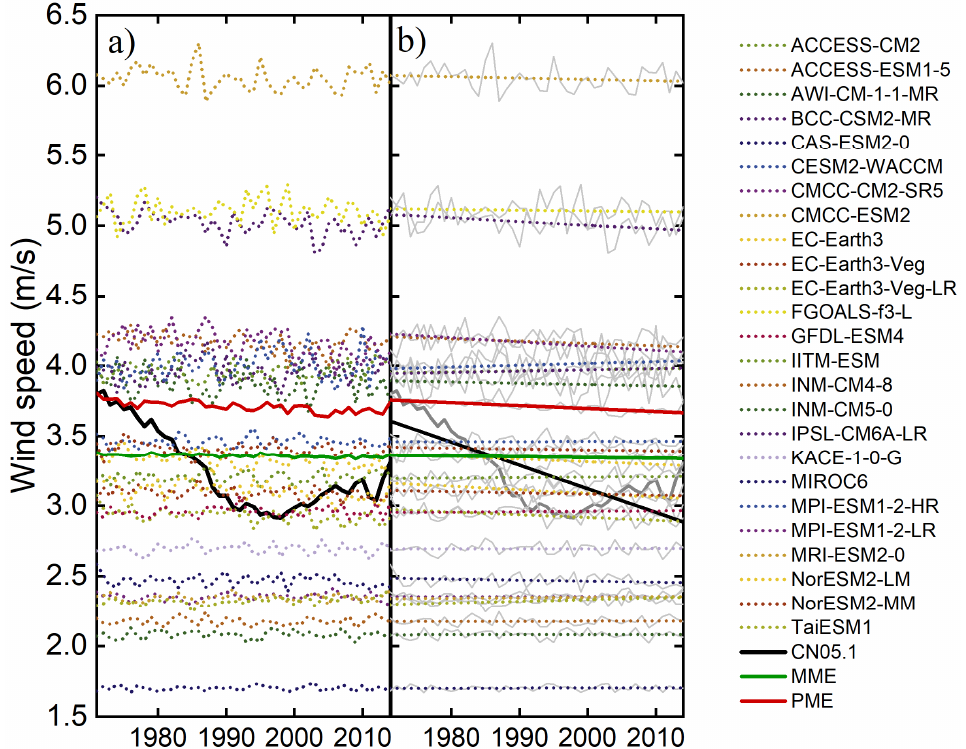
Figure 1. Variations ( a ) and trends ( b ) of observed (black solid line) and simulated (color dot line, red and green solid line) surface wind speed in the ARNC from 1971 to 2014.